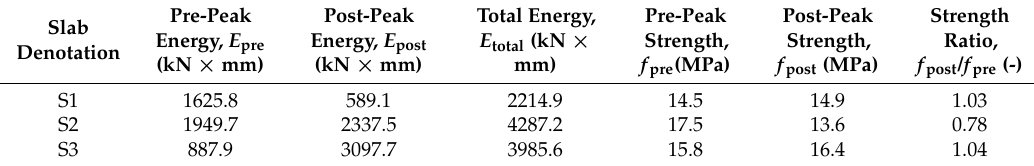
Figure 13. Pre-peak and post-peak strength analysis of fibre reinforced concrete slab. Table 6. Energy and strength values for fibre reinforced high-performance concrete slabs.